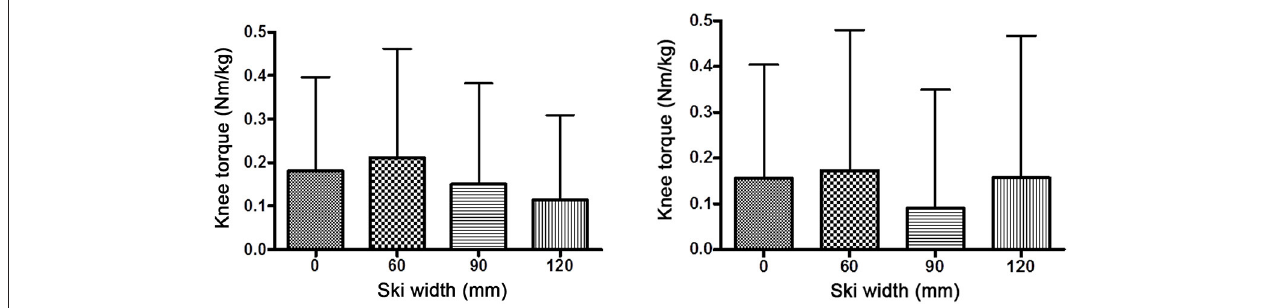
TABLE 1 | The RMS values of the surface EMG attained during different ski widths (normalized to maximal RMS attained during MVC). W0 W60 W90 W120 40 ◦ knee flexion BF 12 ± 6% 17 ± 10%** 24 ± 16% **,## 35 ± 25%**,## ST 8 ± 4% 6 ± 4% 7 ± 4% 8 ± 6% 60 ◦ knee flexion BF 16 ± 9% 17 ± 9%** 19 ± 10%* 24 ± 16%**,## ST 15 ± 8% 12 ± 8%** 11 ± 6%** 11 ± 7%** Asterisks indicate significant differences from central position values ( ** P < 0.01; * P < 0.05). Number signs indicate significant differences from narrower position values ( ## P < 0.01). BF, biceps femoris; ST, semitendinosus; RMS, root mean square; EMG, electromyography; MVC, maximal voluntary